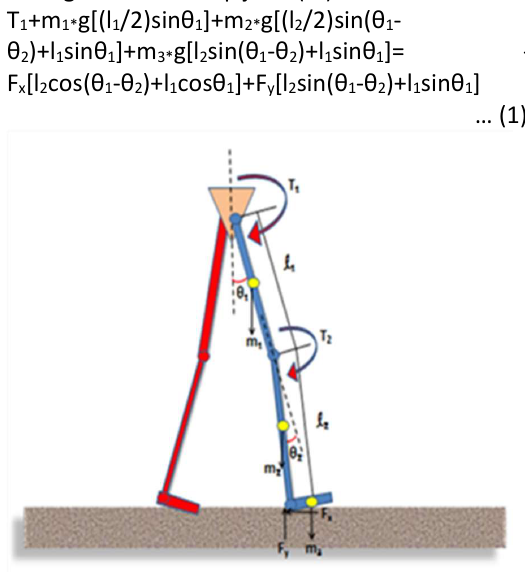
Fig. 1. 1 st double support phase. 2- Stance Phase - Single limb stance: In